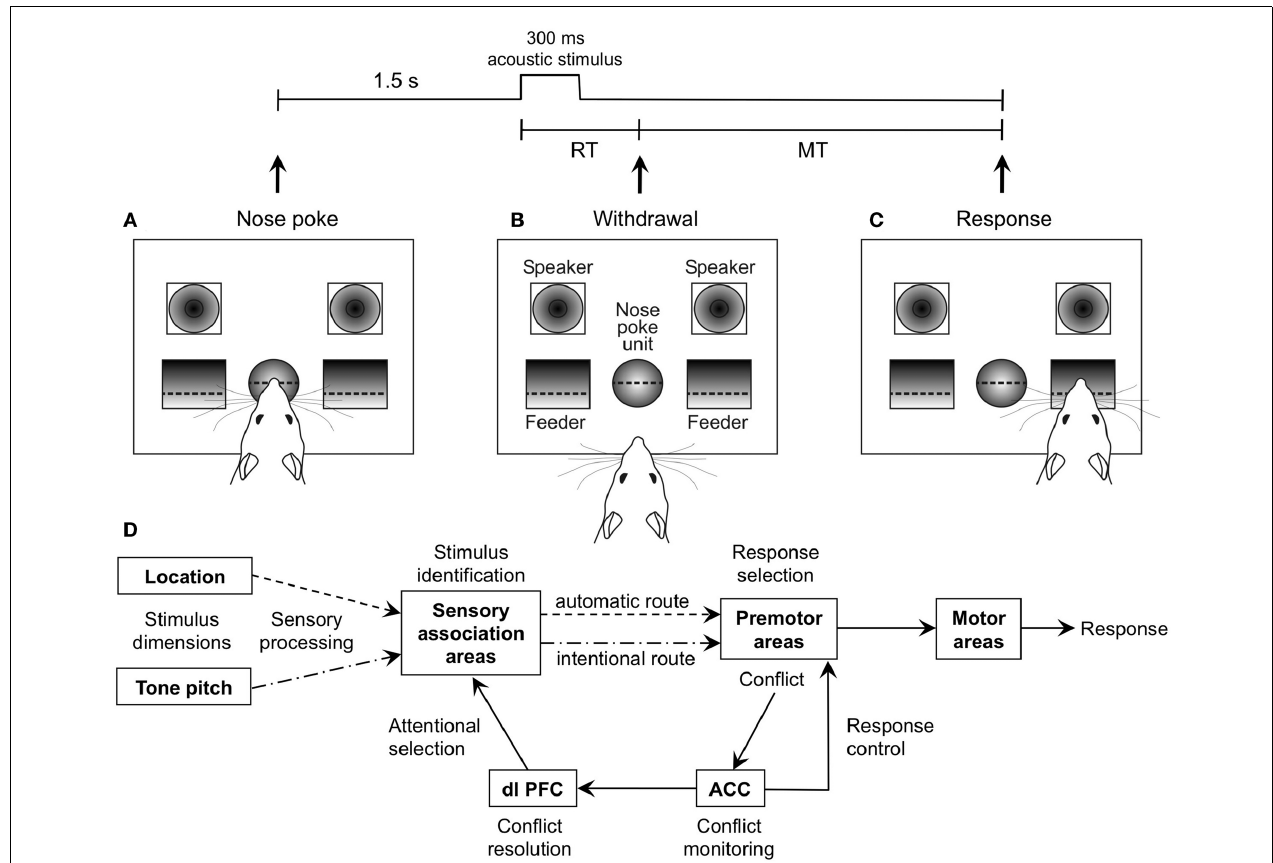
stimulus pitch (10/15kHz), the rat moves to one of the pellet feeders (left/right).The time from withdrawal from the nose poke unit to entering of the pellet receptacle is measured as movement time (MT). (D) Dual route model, after Botvinick et al. (2001), Hommel et al. (2004), Kerns et al. (2004), and Zhang et al.